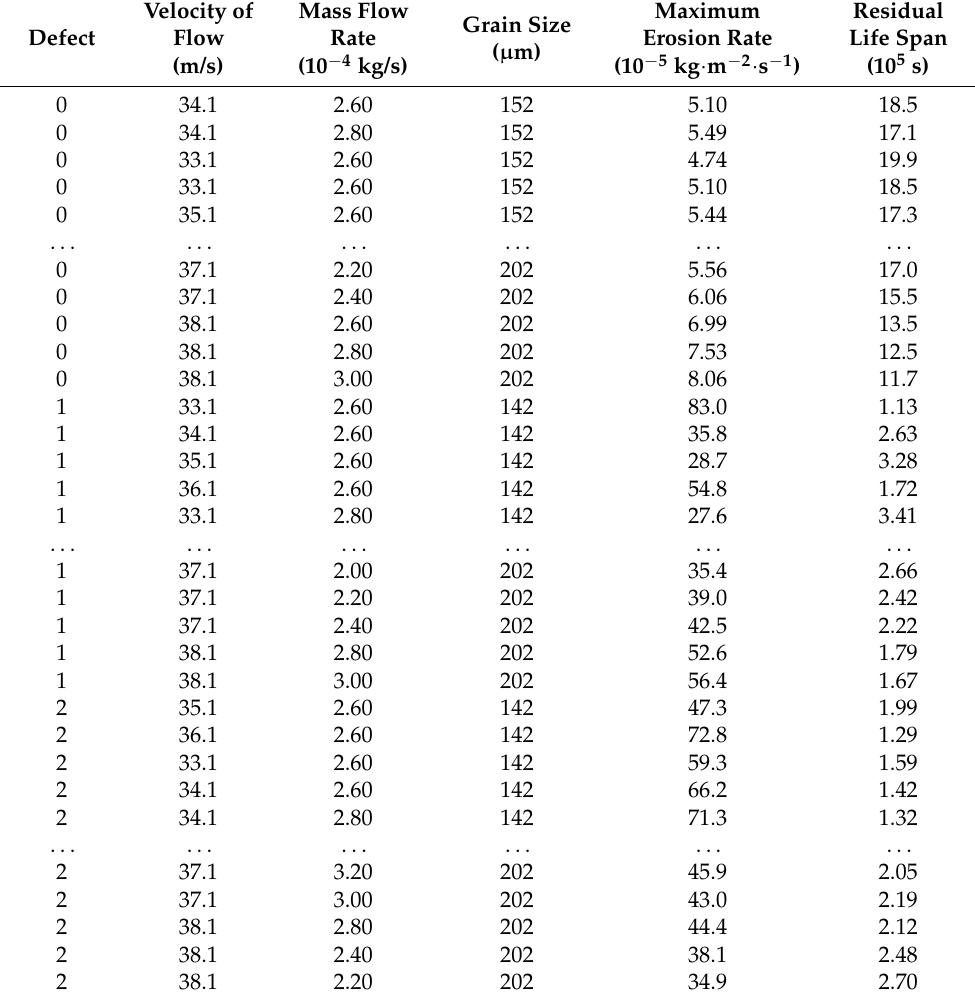
Table 6. Erosion rate and residual life sample